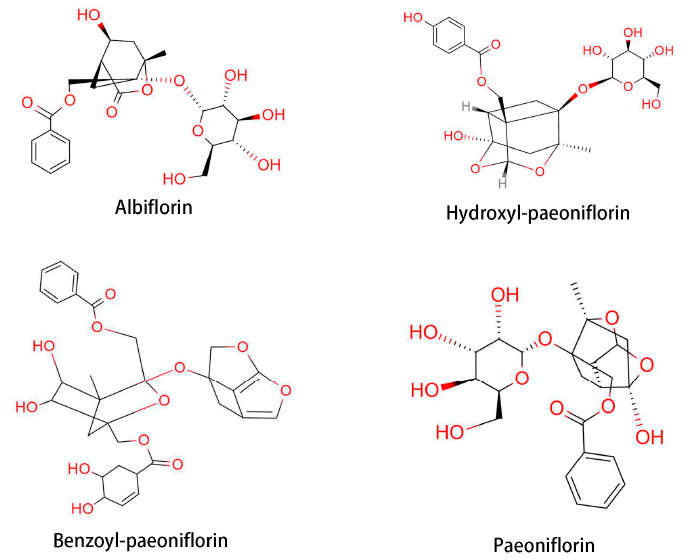
Figure 4. Structures of the principal constituents in total glycoside of paeony (TGP). Paeoniflorin, a monoterpene glucoside, is a major active component of TGP, constitut- ing over or equal to 40% of the total components. Paeoniflorin has been reported to possess extensive anti-inflammatory and immunoregulatory effects [57,62]. Paeoniflorin can diminish pain, joint swelling, synovial hypertrophy, bone erosion, and cartilage deg- radation in experimental arthritis [63,64]. It has been reported that paeoniflorin alleviated AA in rats by inhibiting DC maturation and activation [65]. Paeoniflorin also regulates immune function by affecting splenic T cells in rats with AA [66]. Clinical trials of paeoni- florin in the treatment of RA have been conducted in many hospitals in China. For exam- ple, paeoniflorin was shown to be a safer option to substitute DMARDs for long-term RA treatment [67]. As a result, paeoniflorin was approved for RA treatment and marketing in 1998 by the China Food and Drug Administration [68,69]. Clinical data have shown that paeoniflorin effectively relieves the symptoms and signs of RA without causing signifi- cant adverse effects [58]. In one study, 92 children with juvenile idiopathic arthritis hospitalized at Zhengzhou Children’s Hospital from March 2017 to March 2019 were treated with paeoniflorin. They were randomly divided into treatment and control groups (n = 46). The levels of IL-6, IL- 1, and TNF- α in both groups were significantly lower after treatment than before treat- ment. The levels of IL-6, IL-1, and TNF- α in the treatment group were significantly lower than those in the control group [70]. Paeoniflorin is also recommended for the treatment of other autoimmune diseases, such as systemic lupus erythematosus, psoriasis, diabetes mellitus, diabetic nephropathy, ankylosing spondylitis, and immune liver injury [71–74]. 2.7. Astragalus membranaceus Bunge Radix Astragali ( Astragalus membranaceus Bunge) is one of the most famous Oriental traditional medicines that has been used for many years [75]. It is sold worldwide as die- tary supplements in the form of tea, beverages, soup, trail mix, and capsule [75,76]. Radix Astragali has been reported to exert hepatoprotective, antioxidative, antiviral, anti-hyper- tensive, and immunostimulatory properties [77,78]. It has also been reported to strengthen superficial resistance, drainage action, and new tissue growth [79,80]. Total flavonoids of astragalus (TFA) are the main active components isolated from A. membranaceus [77]. Jinxia et al. (2018) showed the immunomodulatory and anti-inflammatory mechanisms of TFA [81]. The mRNA expression levels of TNF- α , IL-6, IL-1 β , IL-10, iNOS, and COX-2 were examined by RT-PCR in LPS-stimulated RAW 264.7 macrophages after treatment